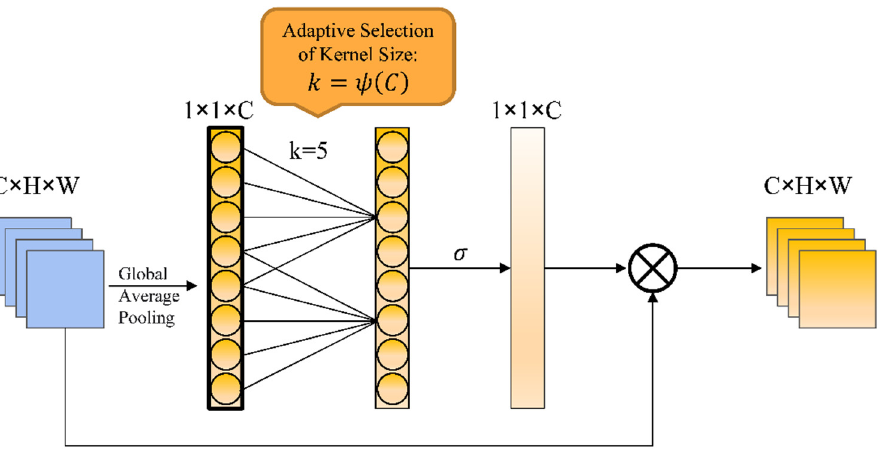
Figure 2. Efficient channel attention (ECA) module diagram. After global average pooling, the channel weights are generated by one-dimensional convolution of size k, and k is adaptively determined by the channel dimension.